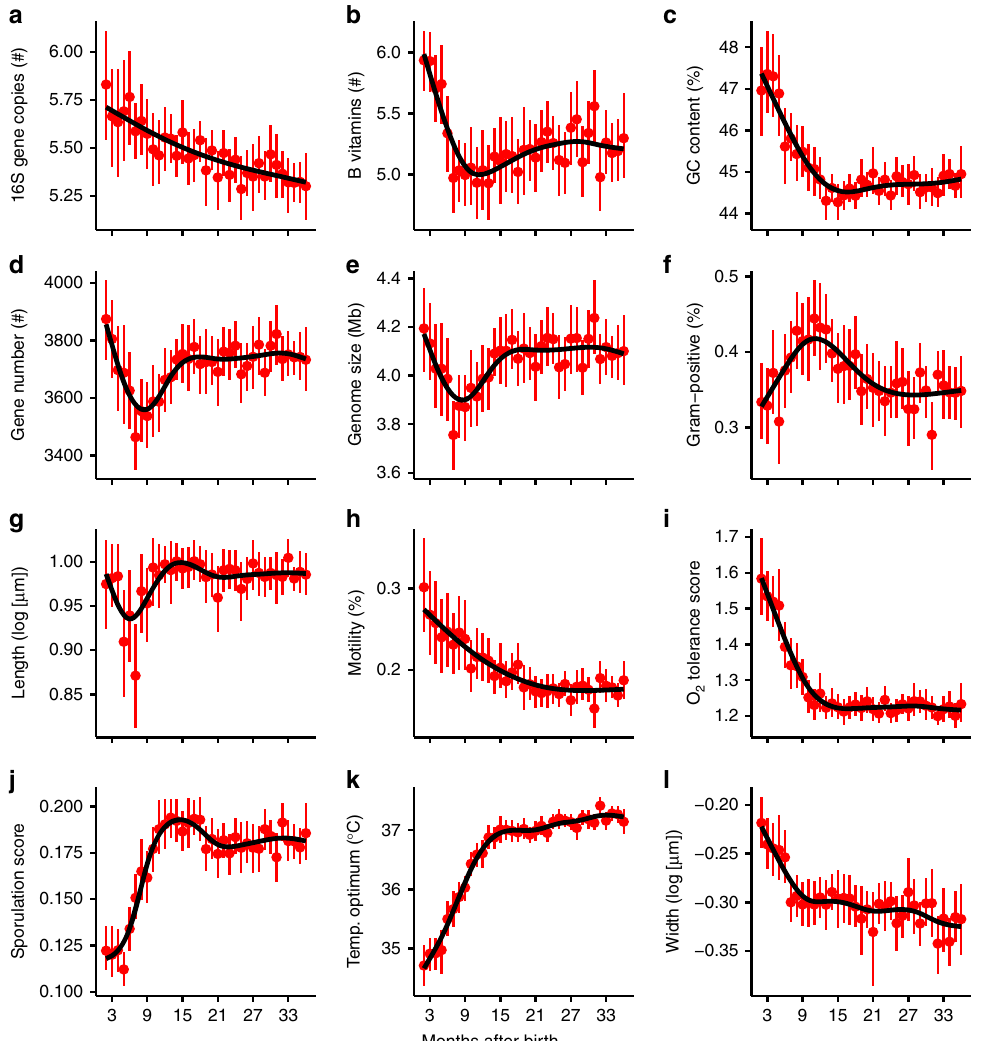
Fig. 2 Abundance-weighted trait means over gut succession. Filled red circles show average abundance-weighted means of predicted trait values of gut microbiomes of up to 56 infants in each month of development ( a - l ). N is equal to the number of samples in each month, and ranges from 27 to 59. Vertical red lines show 95% con fi dence intervals. Black trendlines were fi t using generalized additive